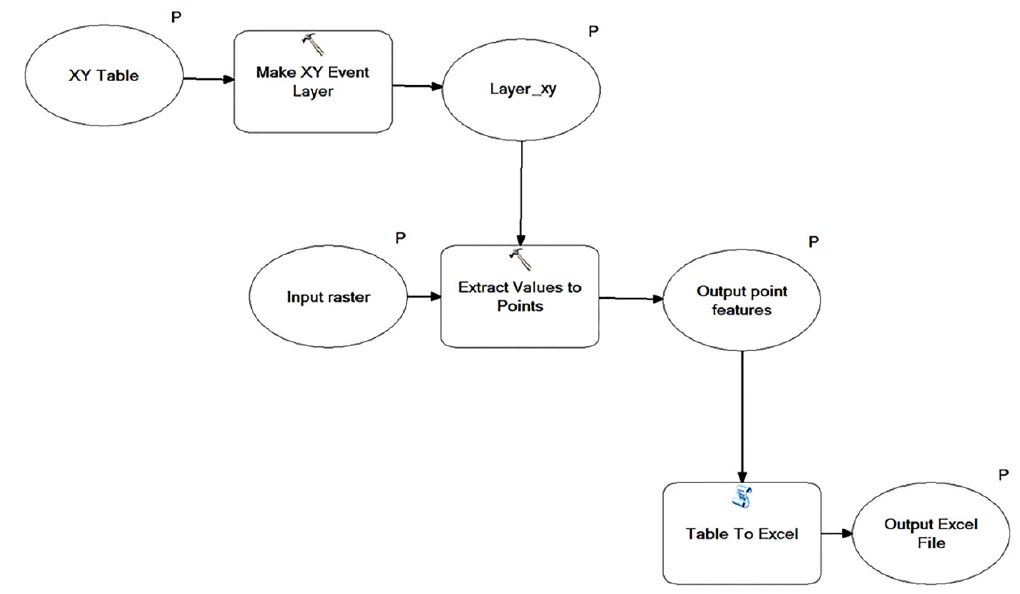
Figure 3. The functional diagram for the determination of XYZ coordinates based on pixel coordinates for raster images in the Mercator projection.